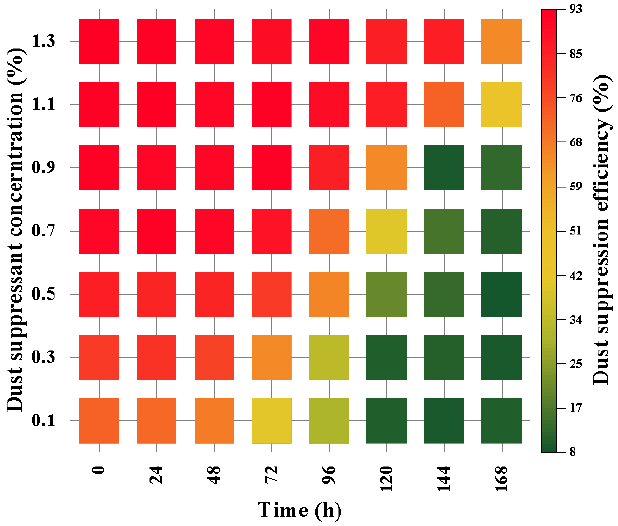
Figure 7. Dust suppression rate of dust suppressant at different times.